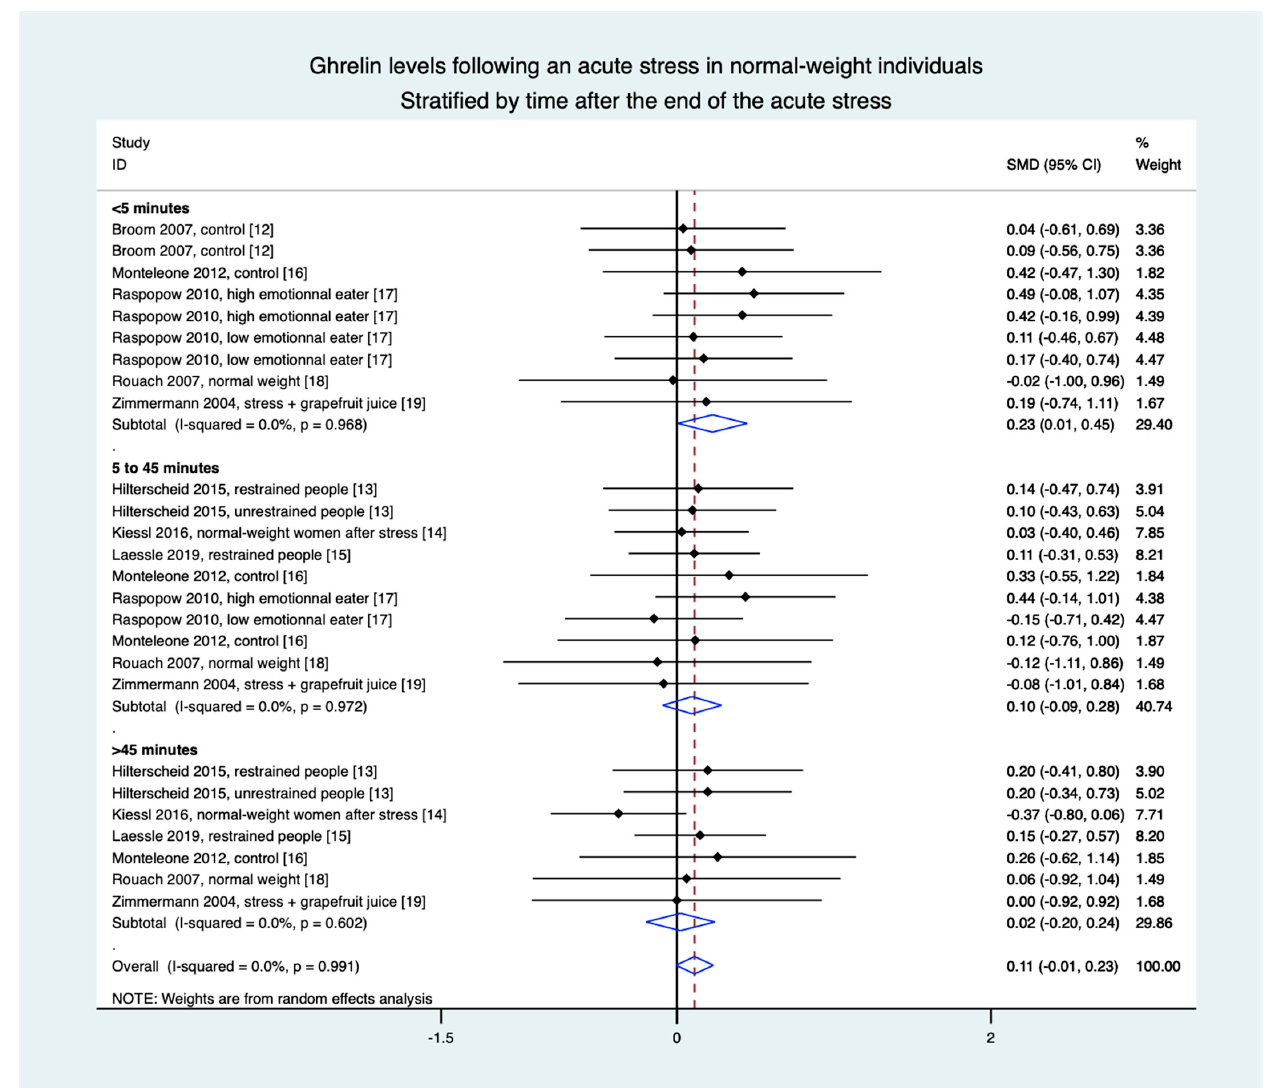
Figure 4. Meta-analysis of ghrelin levels after acute stress compared to baseline levels in the normal-weight population, stratified by time after the initiation of the acute stress intervention.